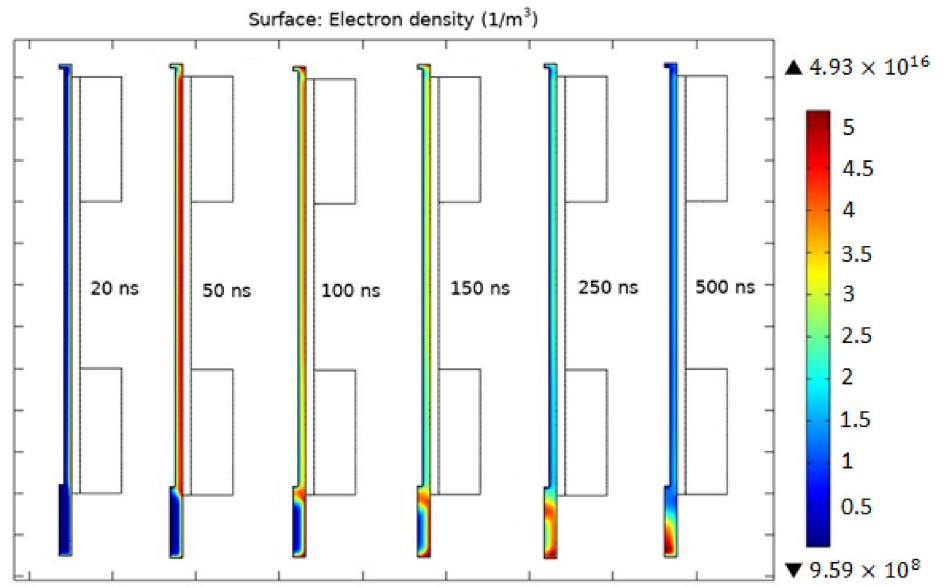
Figure 6. JDBD propagation sequences out of the